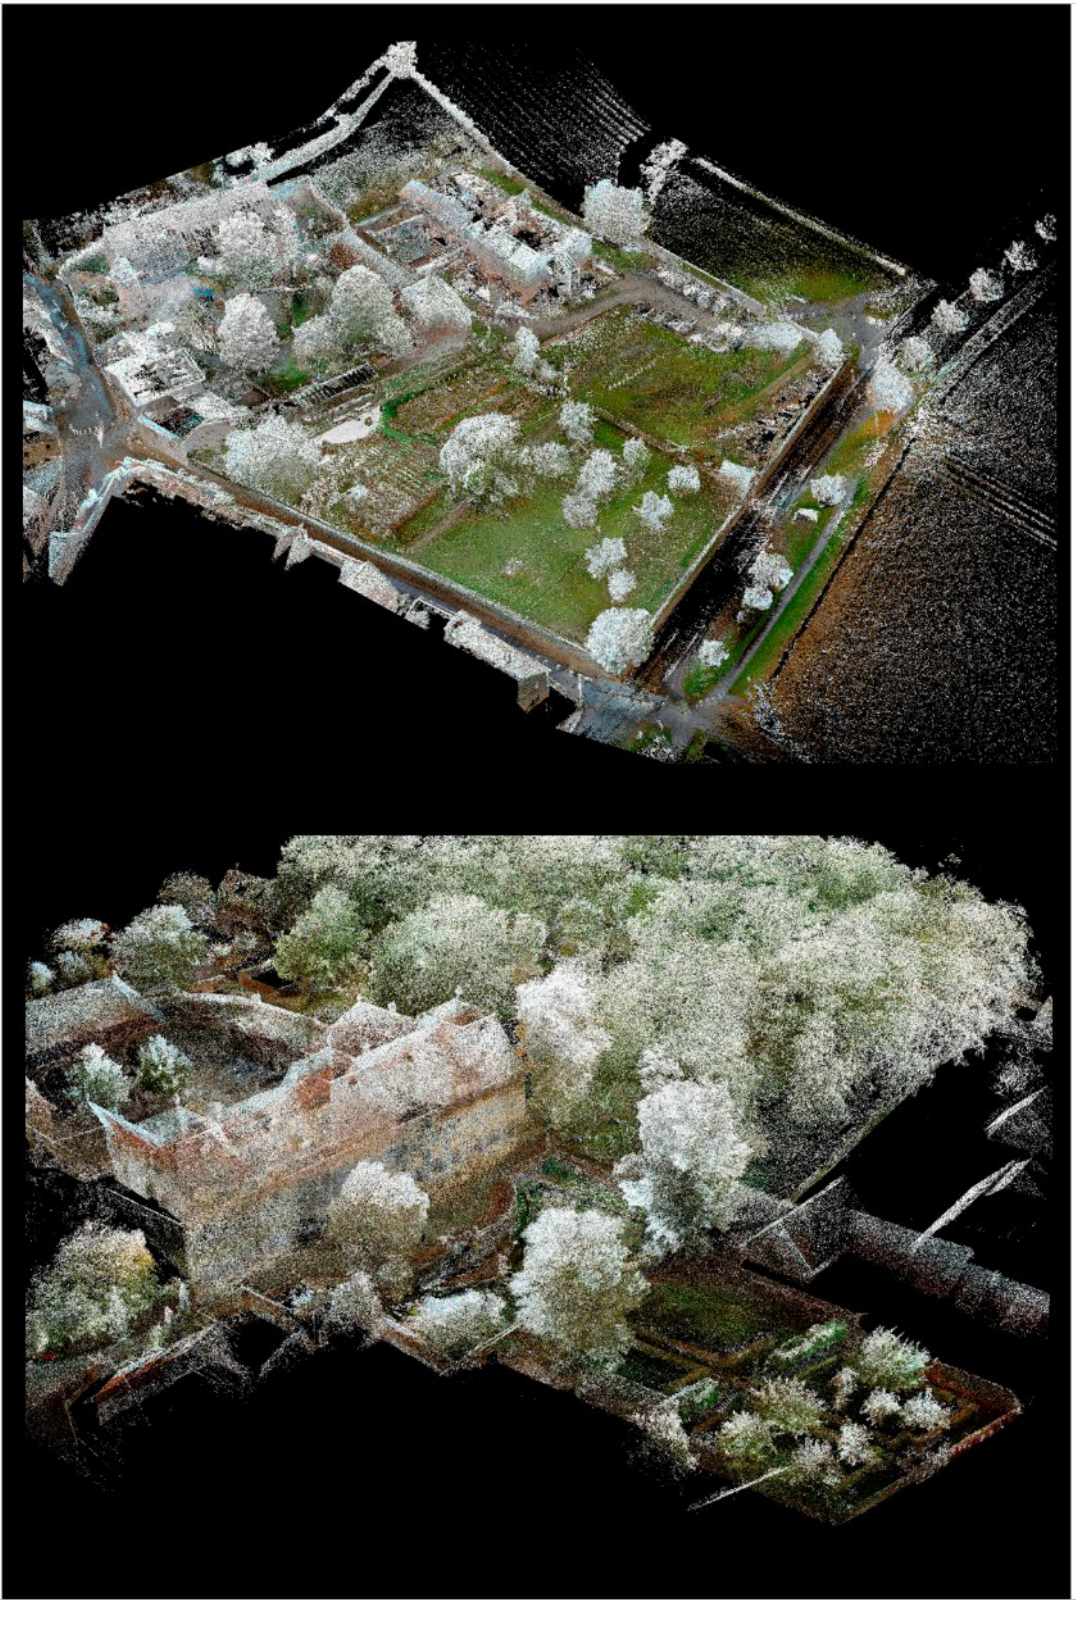
Figure 4: Complete 3D coloured pointcloud of Ebracher Hof in Mainstopheim (top) and Oberschwappach (bottom). The colour comes from the action cam. The botanic features as well as paths and walls are clearly